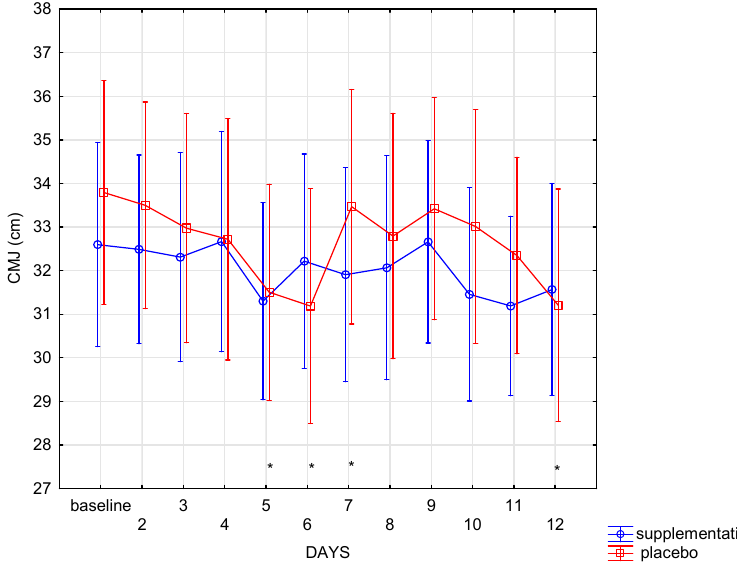
Figure 4. Countermovement jump (CMJ) height in subsequent days in SUP and PL groups (* significant change ( p < 0.05) to baseline in PL group).